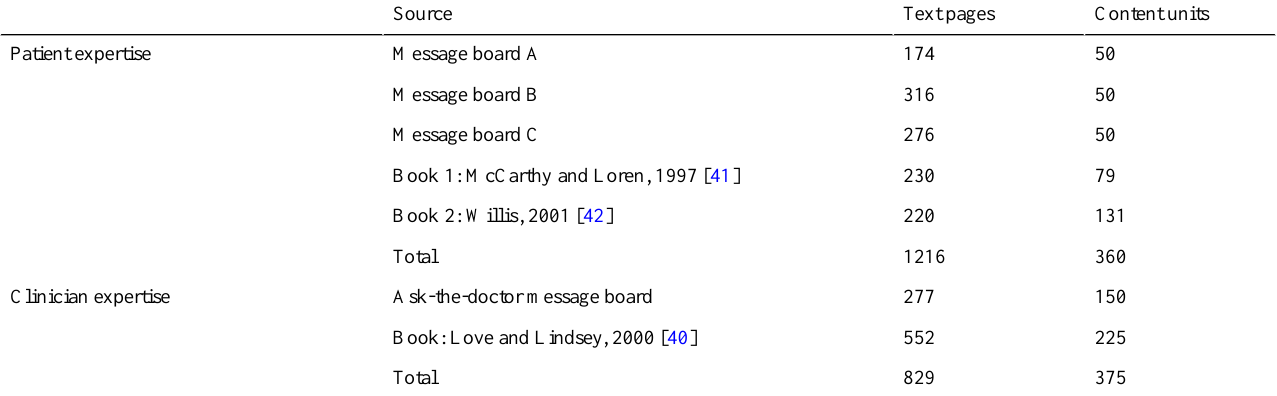
Table 2. Characteristics of message boards